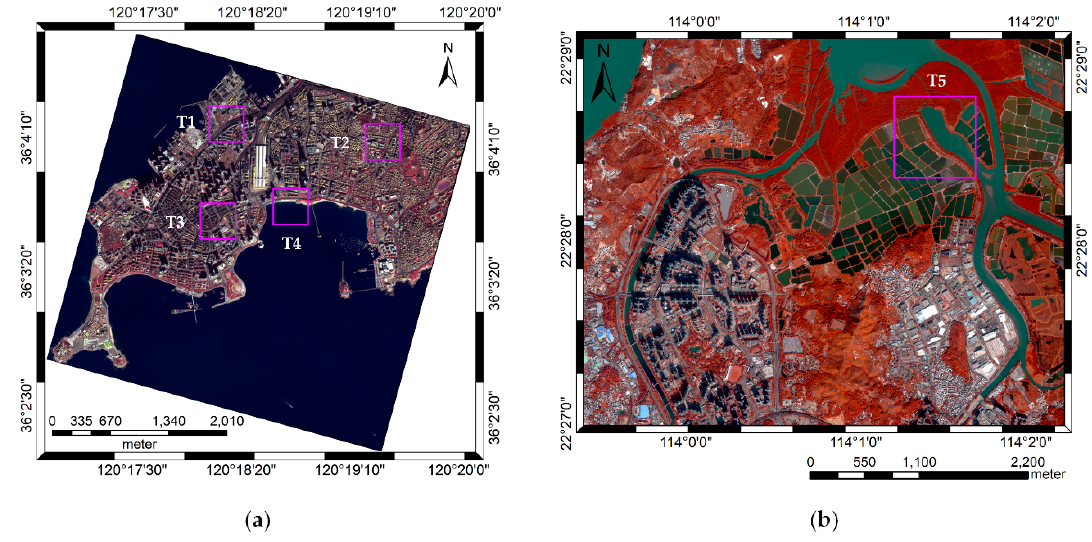
Figure 3. The study area and the four zoomed-in representative area. ( a ) Gaofen-2 image of Qingdao; ( b ) Worldview-2 image of Hong Kong.